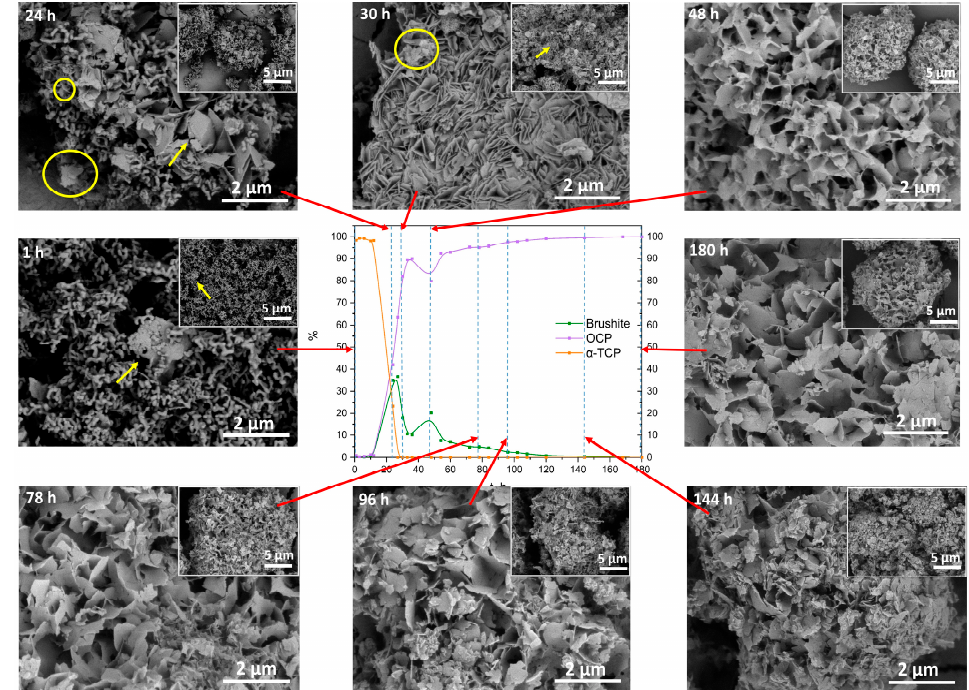
Figure 8. Scanning electron micrographs of α‐ TCP transformation to OCP (100 × SC), observed at specific time points (1 h–180 h) indicated on each SEM image (scale bar 5 μ m and 2 μ m) and connected (red arrow) to the according point (dashed line) in the phase content diagram based on the XRD quantitative data. Yellow arrow indicates possible DCPD crystals, while the yellow circle is marking the potential OCP plates.